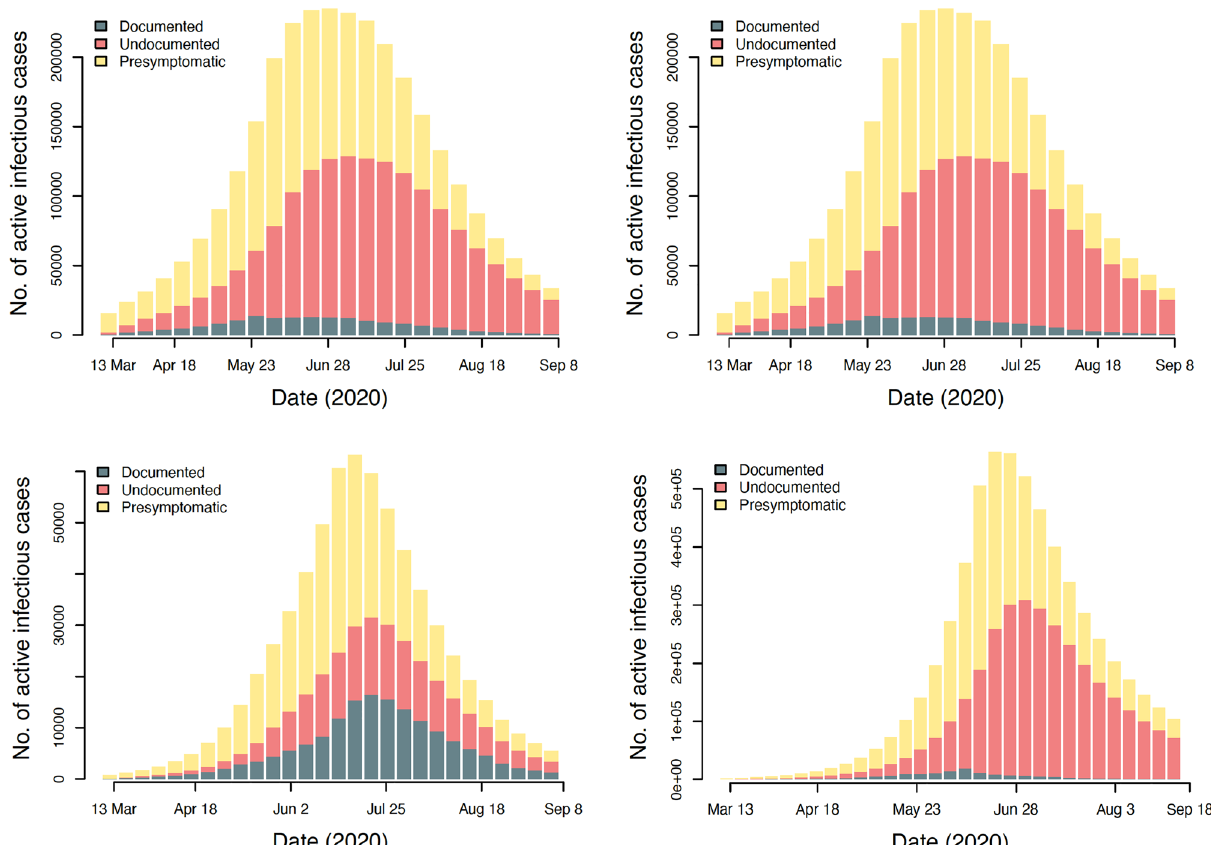
Figure 7. The estimated number of infected cases that were active (presymptomatic, symptomatic, and asymptomatic) during the research period in the areas of Makkah, Madinah, Eastern, and Riyadh respectively.